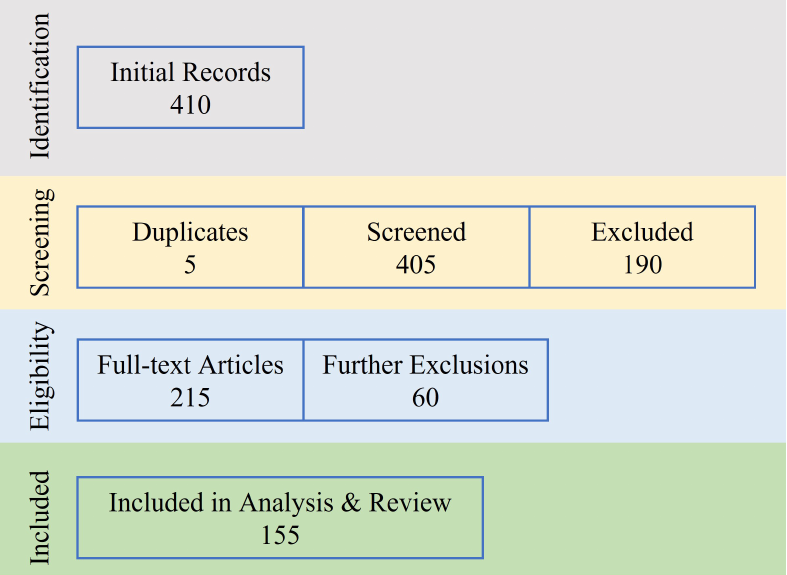
Figure 2. PRISMA components of this review on applications of fine-grained access control in